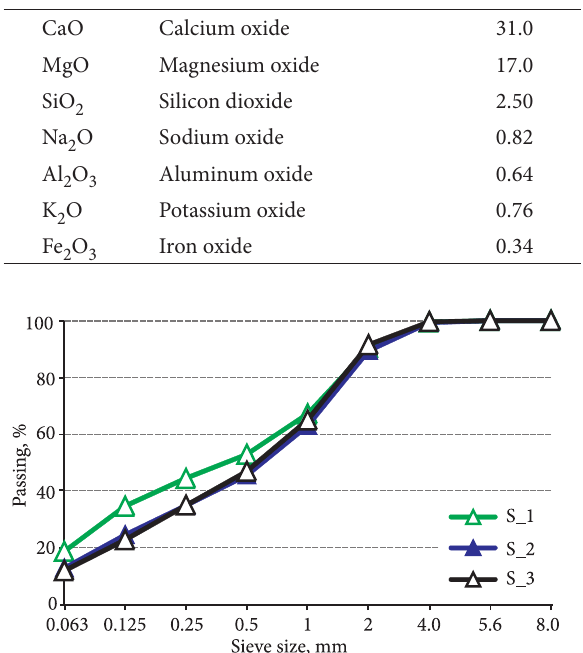
fig. 1. Particle size distribution of dolomite sand